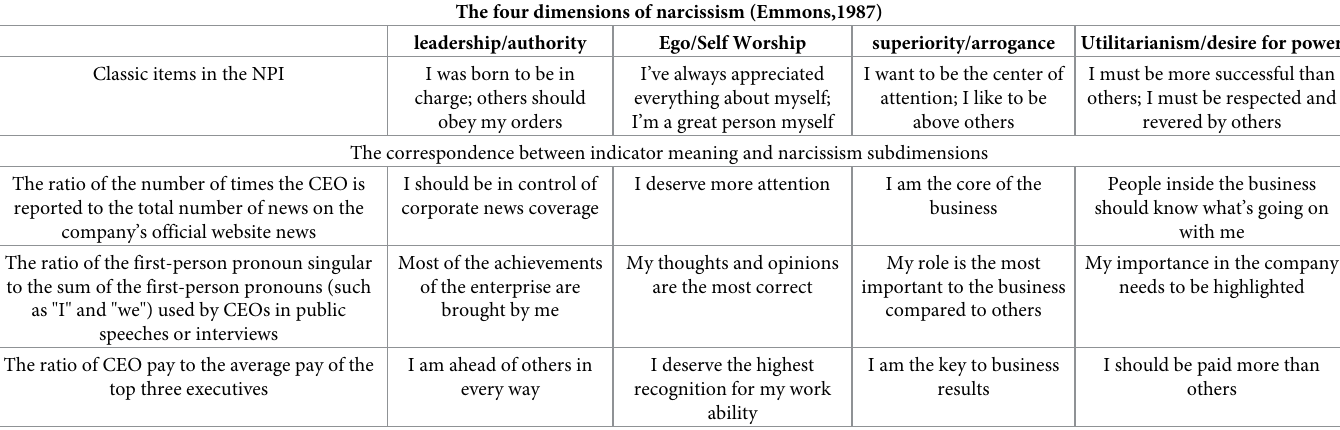
Table 1. The index of CEO narcissism and the four dimensions of